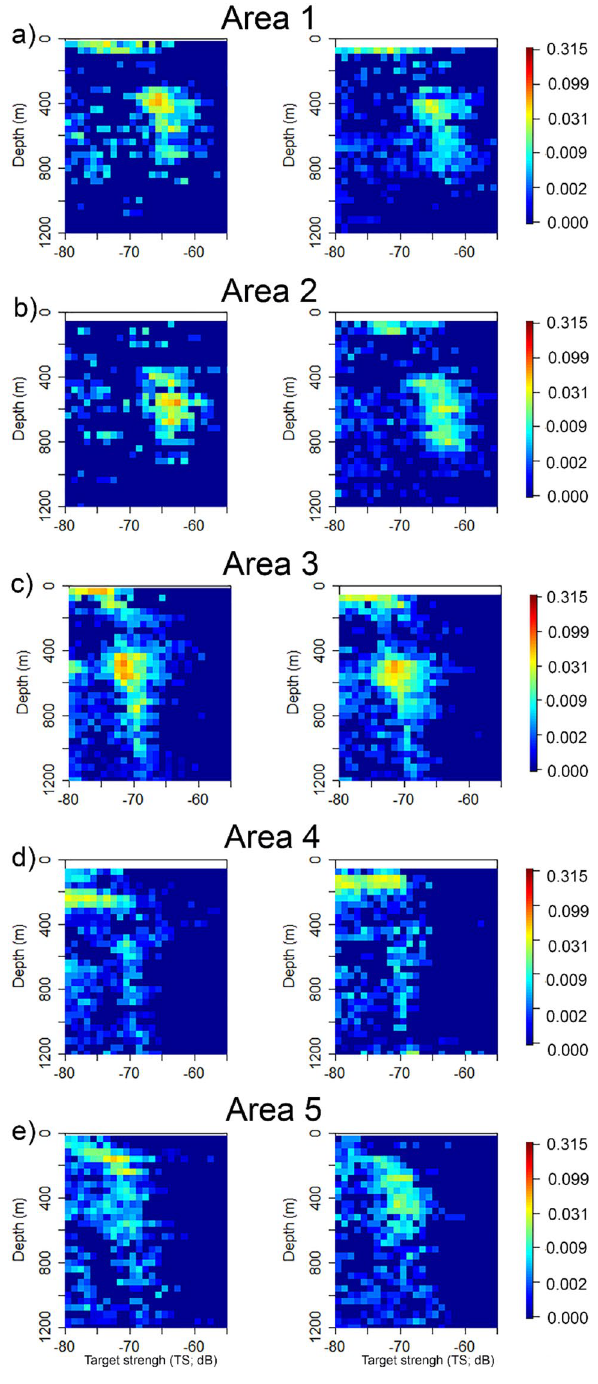
Figure 4. Example of the vertical profiles (down cast on the left and up cast on the right) of TS and densities of echoes detected by the WBAT mounted in the trawl per area. The colour scales indicates the density (number of organisms m −3 ). This figure was created using R version 4.1.3 (2022-03-10) (https:// www.r- proje ct.